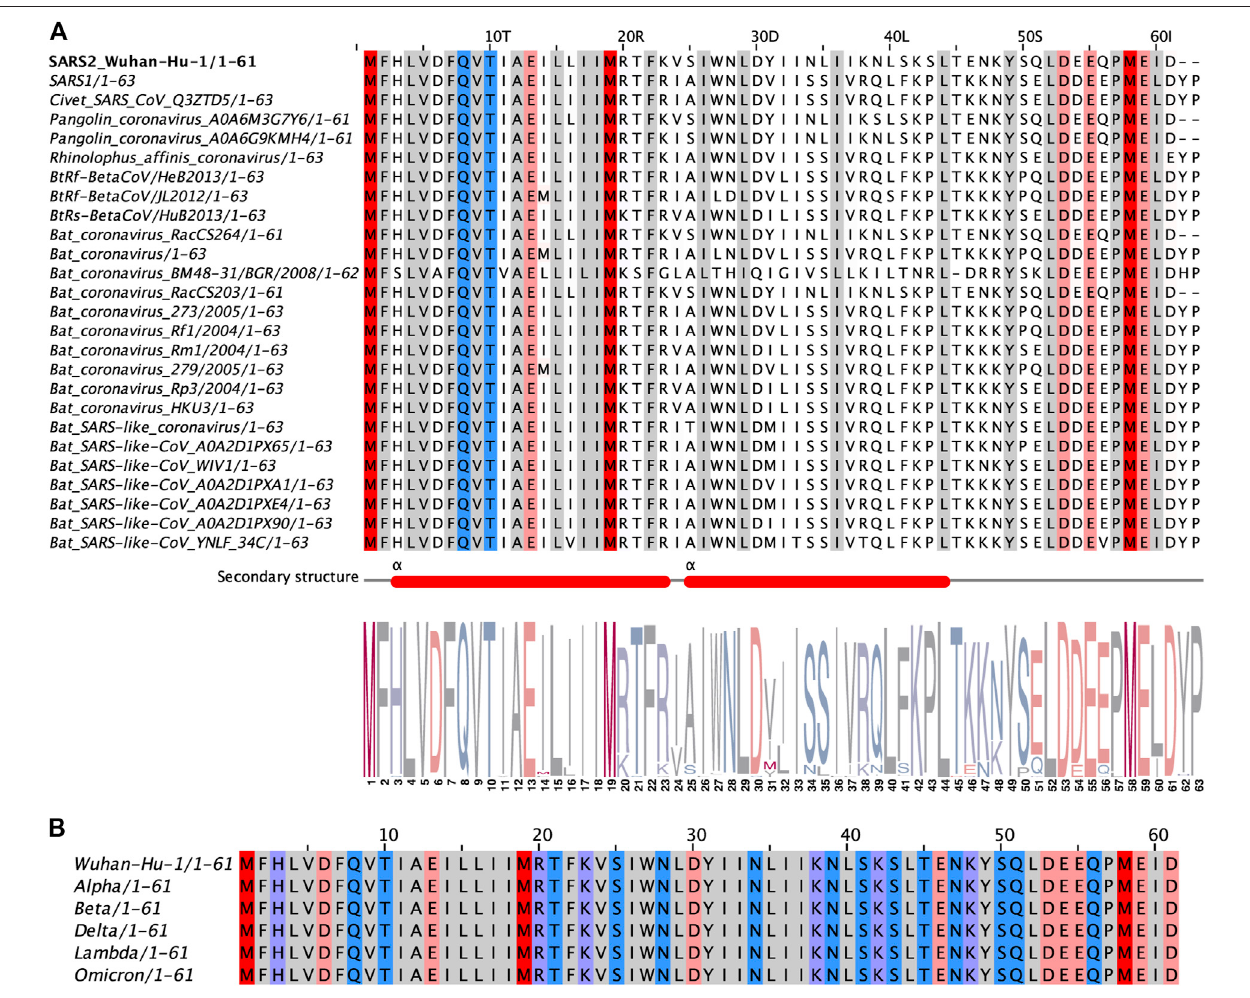
FIGURE 3 | Sequence alignments of sarbecoviruses Orf6 proteins. (A) Alignment of representative sequences across different sarbecoviruses species. The N-terminal motif and C-terminal tail of Orf6 are highly conserved, as illustrated here by a WebLogo (http://weblogo.berkeley.edu). (B) Alignment of sequences from epidemic SARS-CoV-2 variants including Alpha (B.1.1.7 lineage), Beta (B.1.351 lineage), Delta (B.1.617.2 lineage), Lambda (C.37 lineage) and Omicron (B.1.1.529 lineage). Representative sequences of Orf6 homologs are aligned with respect to isolate Wuhan-Hu-1. The high sequence conservation ( > 95%) at each position is highlightedindifferentcolors(Redformethionines,pinkfornegativelychargedaminoacids,purpleforpositivelychargedaminoacids,blueforpolaraminoacidsandgray for hydrophobic amino